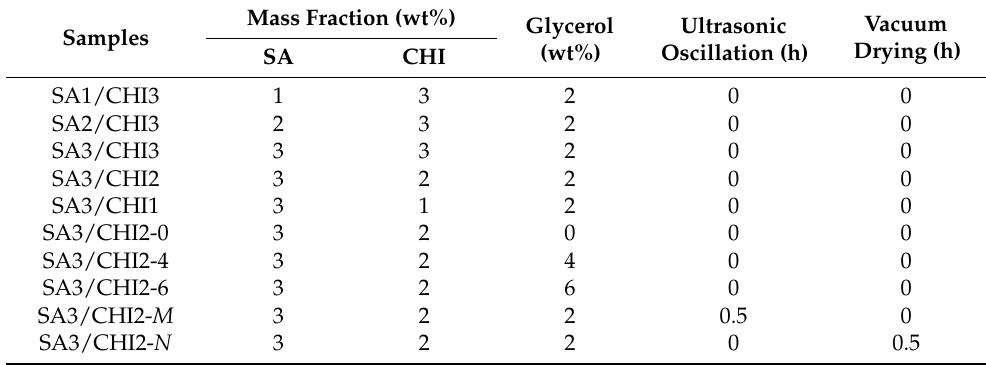
Table 1. Detailed parameters of SA/CHI porous